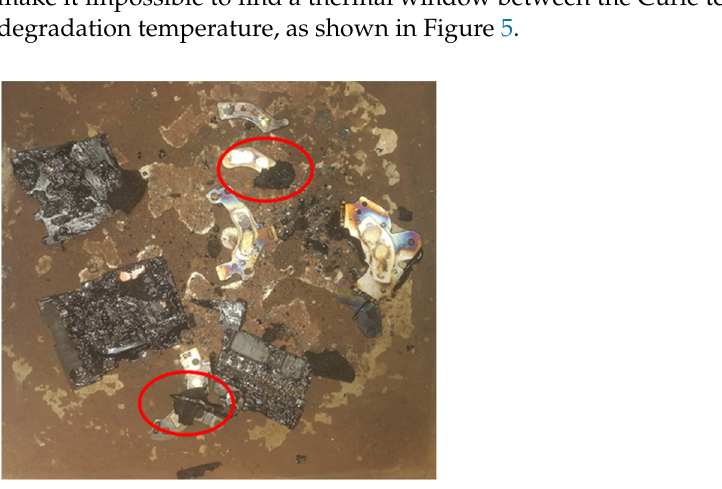
Figure 5. Example of components observed after thermal treatment at 305 °C during 90 min. With the red circles representing the burnt organic parts over metallic elements.